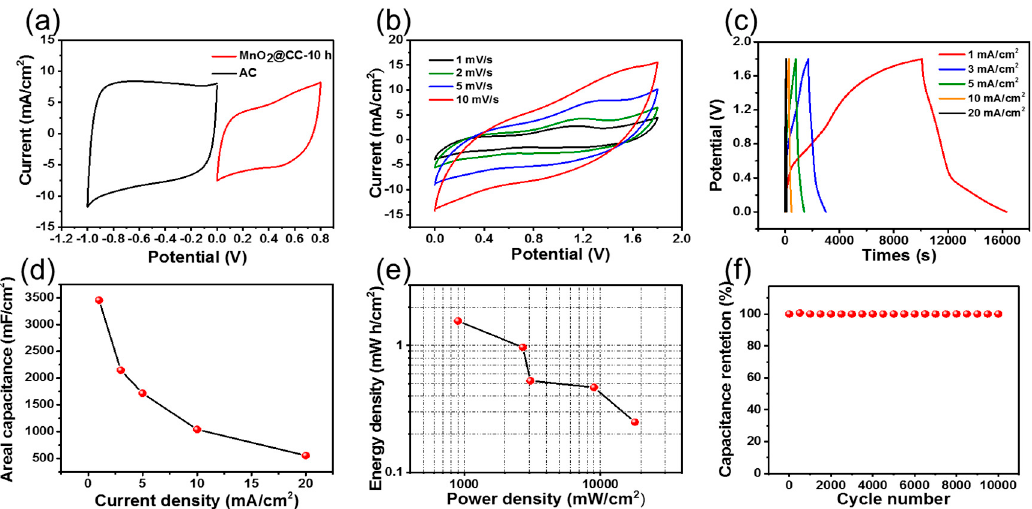
Figure 6. Electrochemical performance of the AC // sulfonated membrane separator // MnO 2 @CC ASC. ( a ) Typical CV curves of the AC anode and MnO 2 @CC cathode in the potential range of − 1 to 0.8 V. ( b ) CV curves at various scan rates. ( c ) Charge–discharge profiles at different current densities. ( d ) Area-specific capacitance. ( e ) Areal energy and power densities of the ACS device. ( f ) Cycling stability of the ASC.